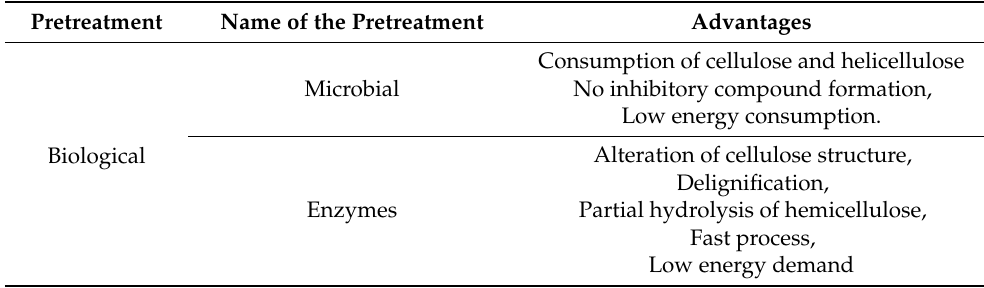
Figure 3. Key steps involved in lignin depolymerization in aerobic degradation. Microbes through their arsenal of enzymes function as soil engineers and play an important role in the pre-treatment for lignocellulose degradation. The importance of biological pre-treatment of lignocellulose are represented in Figure 4 and Table 2. Table 2. Advantages of biological pre-treatments